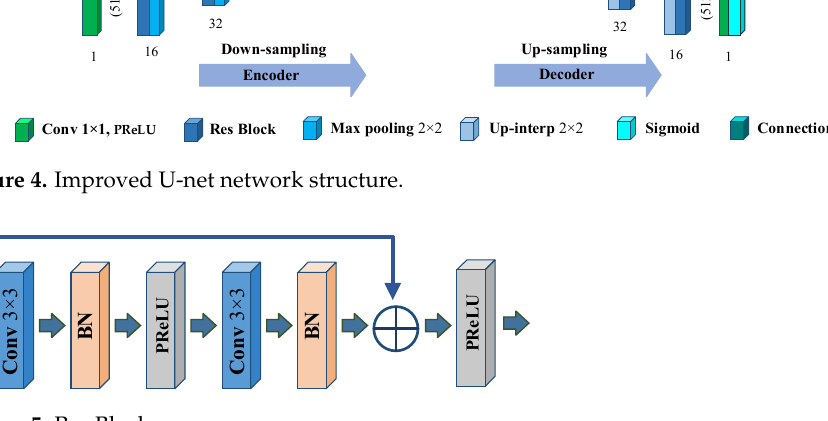
Figure 5. Res Figure 5. Res Block.